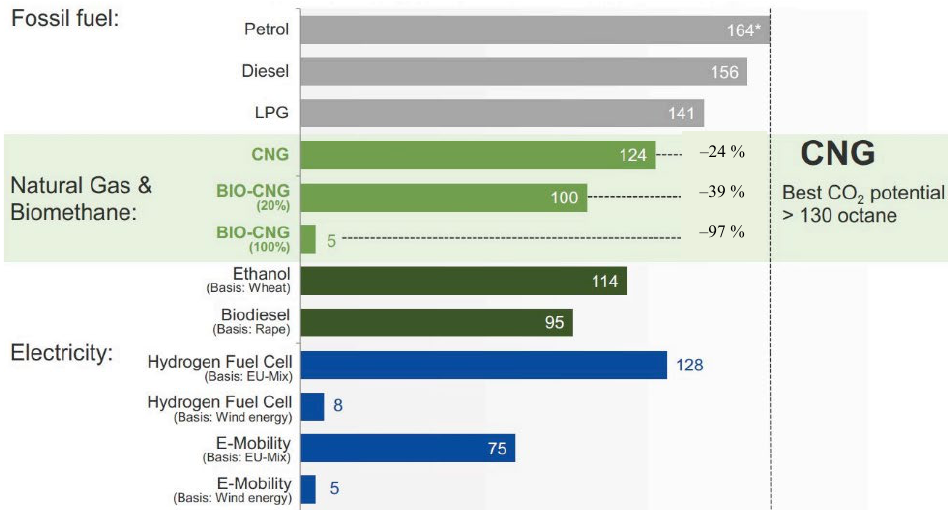
Fig. 1. Well-to-Wheel – GHG emissions in CO 2 g/km